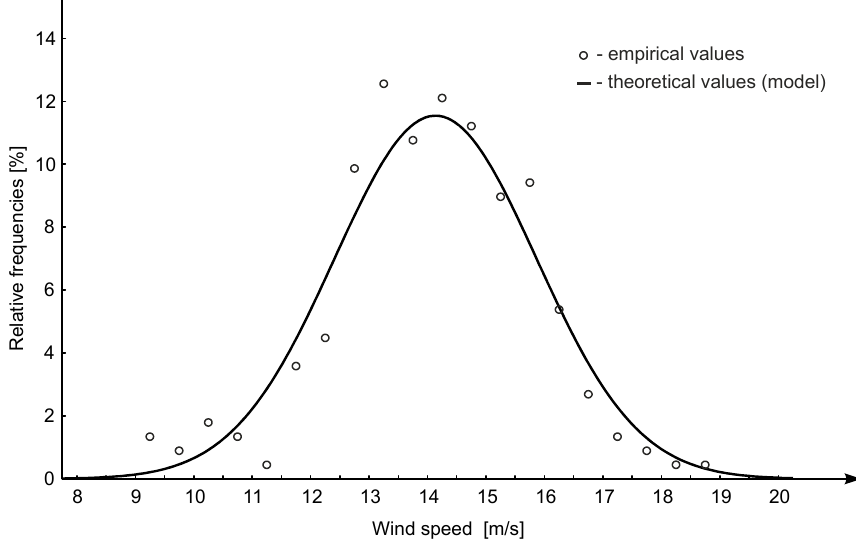
Figure 6. Empirical and theoretical probability density function of 110 kV overhead power lines resistance to load (exposure) in the form of wind occurring in their place of operation.